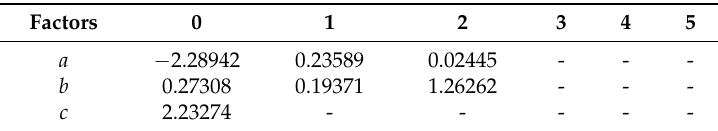
Table 6. Values for a , b and c factors of the df min fit, used to model df min for given kt , kt var , AM and up/down time. The RMS of residuals is 0.0542.